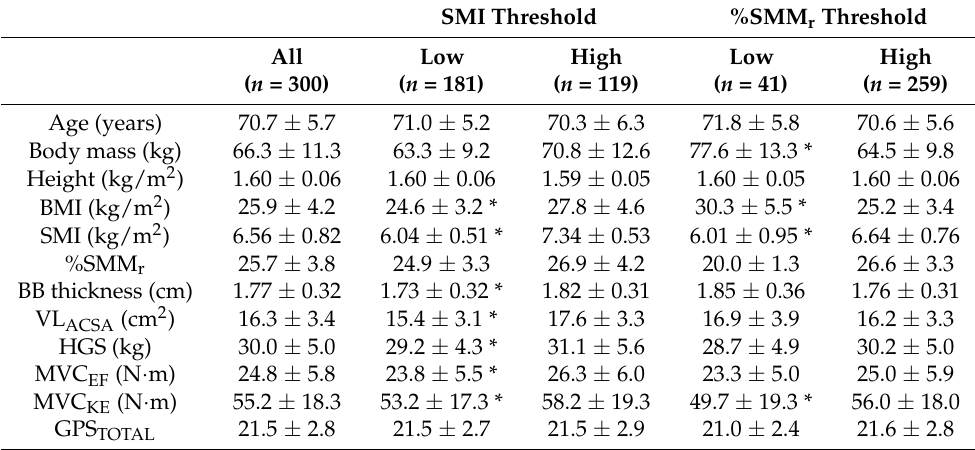
Table 1. Characteristics of all participants and according to pre-sarcopenia